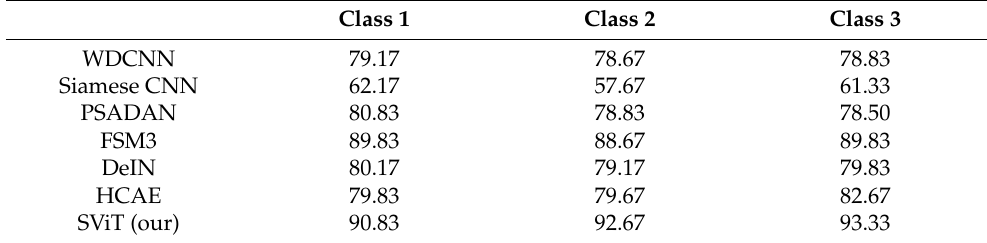
Table 17. Recall (%) comparison for cross-domain task E-D with 1800 training samples per class on the Paderborn dataset.